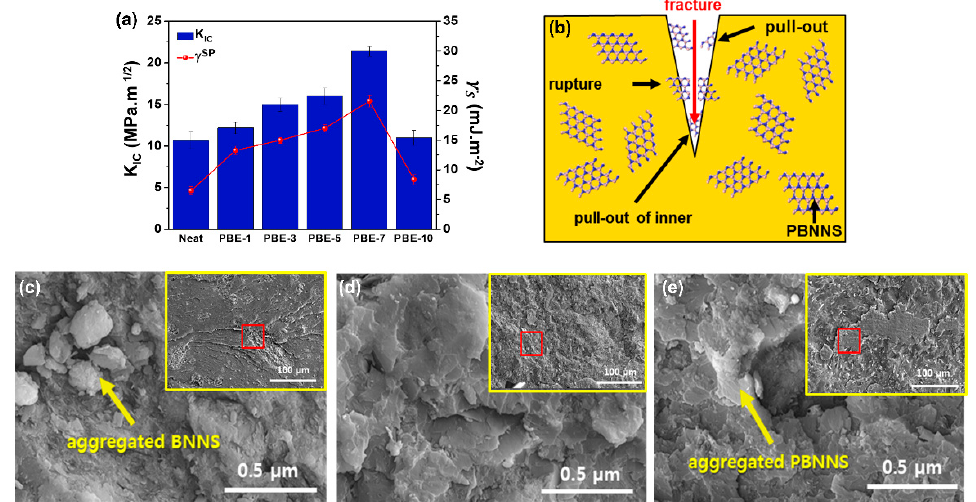
Figure 8. Fracture toughness of the BNNS/epoxy nanocomposites: ( a ) Correlation between specific polar component of surface free energy and K IC , ( b ) fracture mechanism, ( c ) fracture surfaces of the Neat, ( d ) PBE-7, and ( e ) PBE-10.